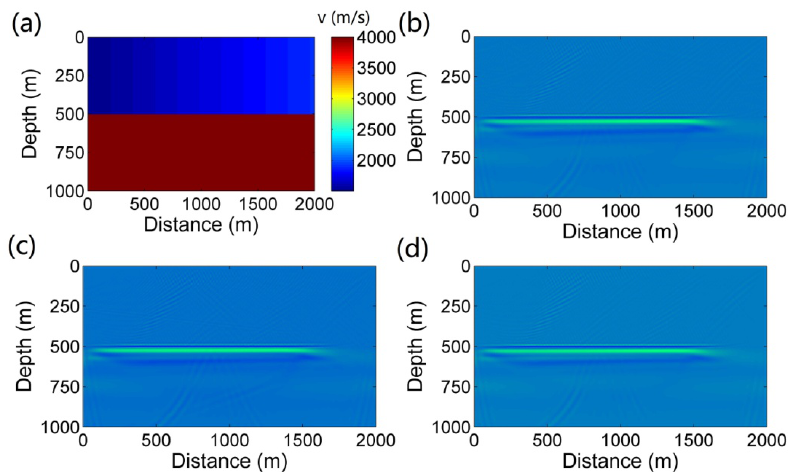
Figure 2. ( a ) The velocity model of the horizontal layer; ( b ) The imaging result of Method 1; ( c ) The imaging result of Method 2; ( d ) The imaging result of Method 3.